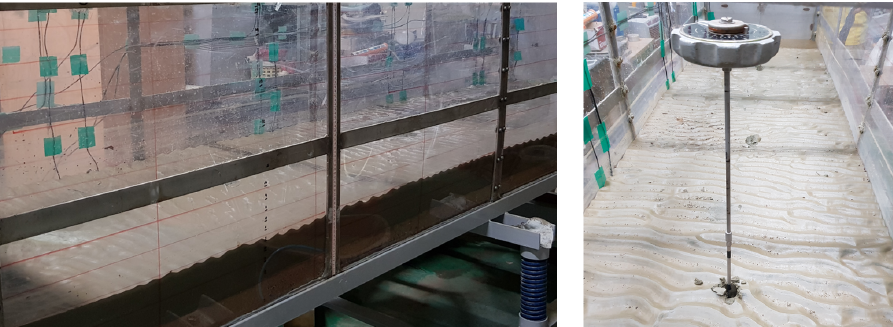
Figure 12. Preliminary shaking of silty sand showing wavelike deformation of the ground surface due to surface waves. Table 2. Properties of the woven polyester geotextile.